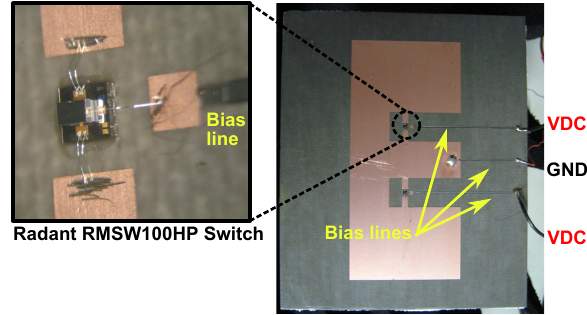
FIGURE 19. Fabricated final optimized frequency reconfigurable E-shaped patch antenna with MEMS switches and a resistive bias line network to minimize interference between the bias lines and the antenna. Adapted from